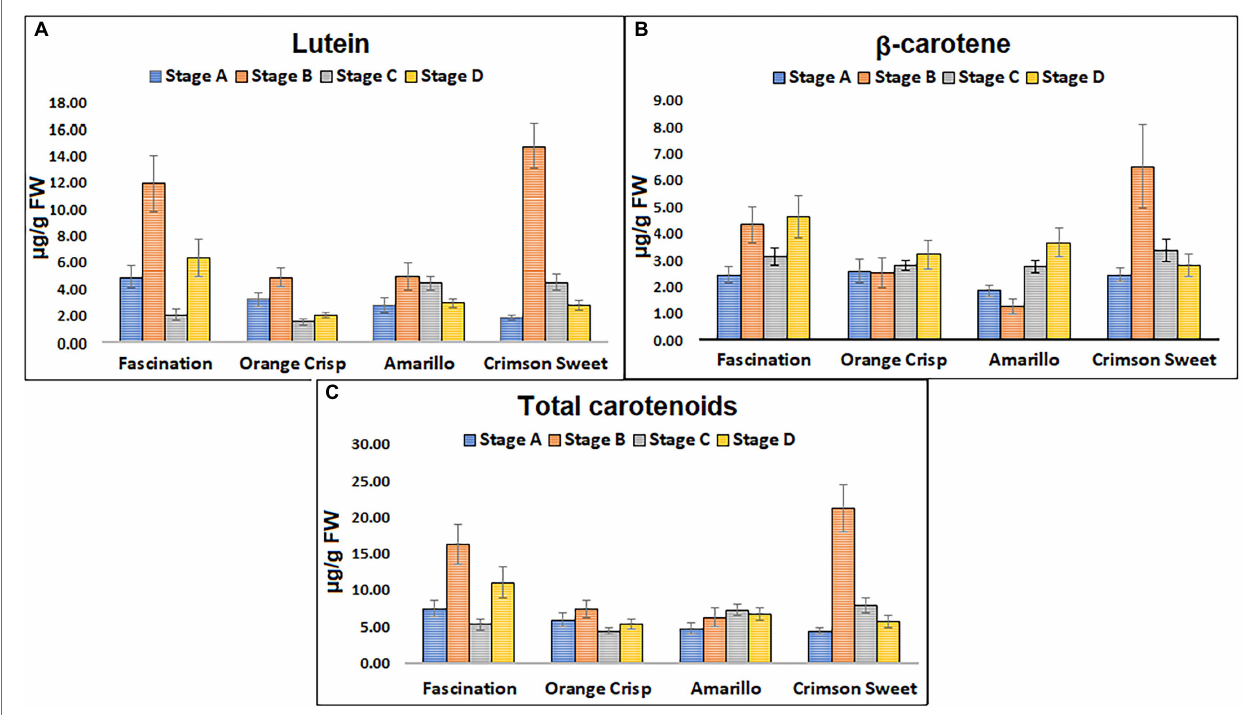
FIGURE 5 | Concentration of individual pigments (A) lutein ( μ g/g FW), (B) β -carotene ( μ g/g FW), and (C) total carotenoids detected at different stages of ripening from the fruit rinds of four different cultivars of watermelon. Error bars represent SD from the average ( n =